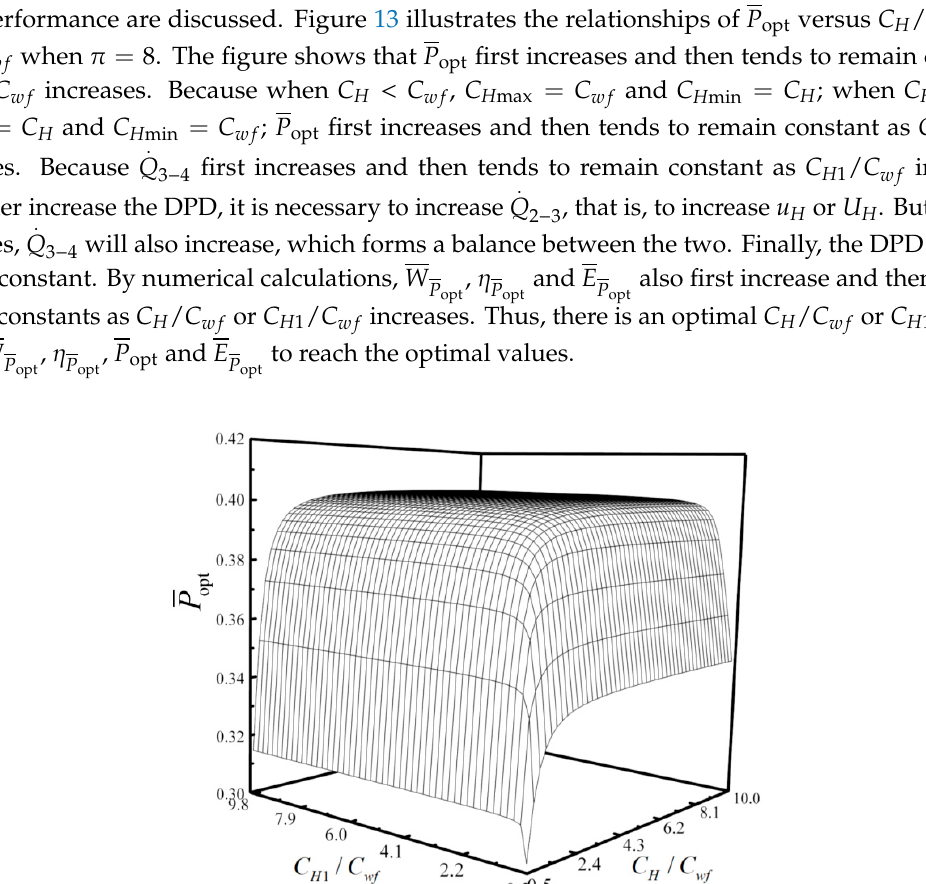
P / C C / C C H wf H wf versus and 1 .